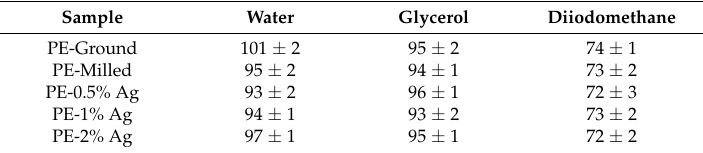
Table 3. Average values of contact angle for the samples in water, glycerol and diiodomethane. Sample Water Glycerol Diiodomethane PE-Ground